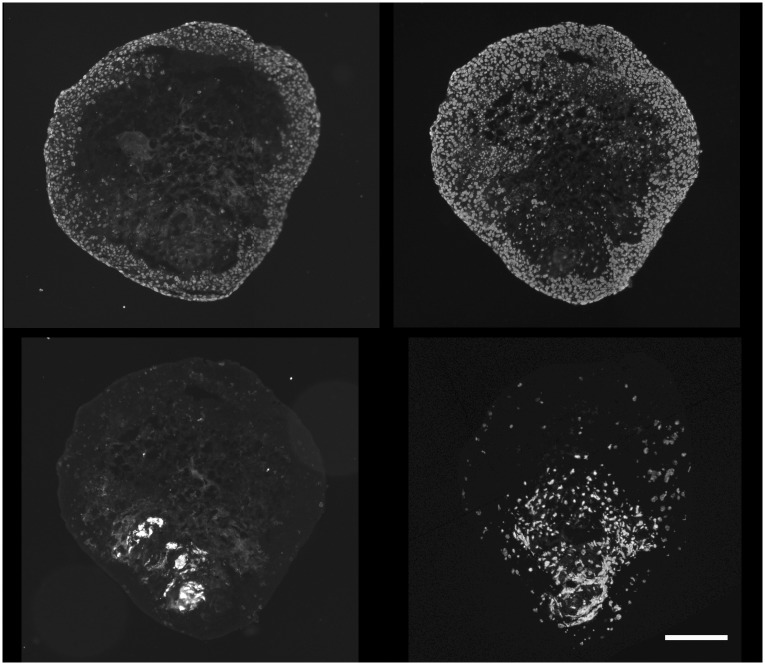
Stromal cells in TF spheroids.6-day TF spheroids retained host tissue components, some of which migrate to characteristic positions in the spheroid. Macrophages (CD11B positive) migrated to the periphery (upper left), and, as in this example sometimes comprised a sizeable fraction of the total cells (indicated by Hoechst 33342 staining of nuclei) (upper right). CD31 positive endothelial cells remain grouped together (lower left) while vimentin positive cells tended to congregate within and around the central hypoxic/necrotic zone as well as the periphery (lower right. (representative of several TF spheroids from 2 preparations—scale bar is 250 μm).